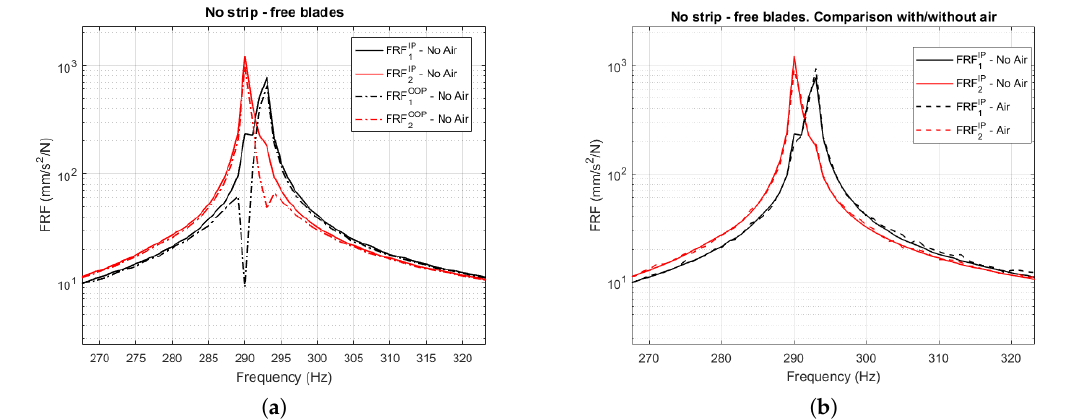
Figure 3. ( a ) The four frequency response functions (FRFs) of the blades without strip and with the compressed air system switched off; ( b ) IP (in phase) FRFs of the blades without a strip in the case of compressed air turned on or